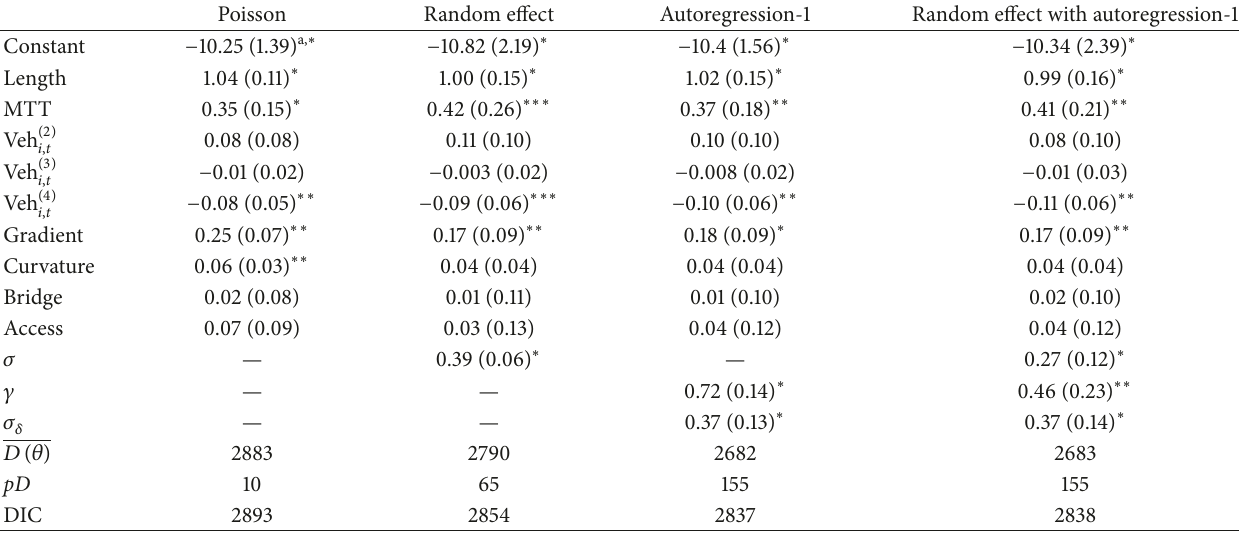
Table 4: Model estimation